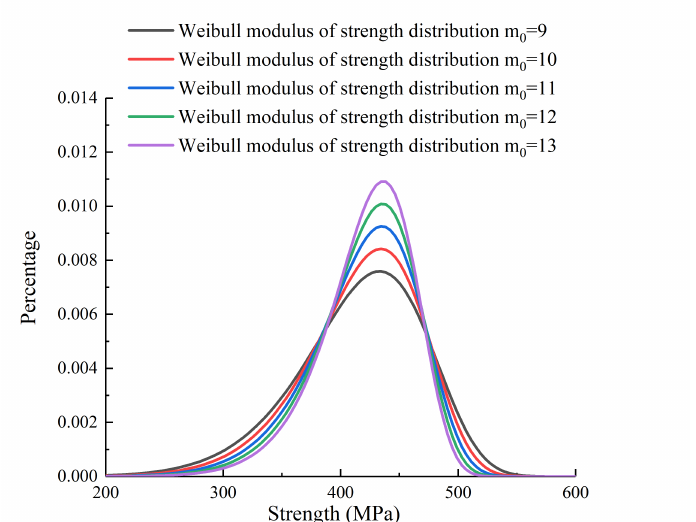
Figure 5. Microscopic strength distributions with different Weibull modulus ( m 0 = 9, 10, 11, 12, and 13).